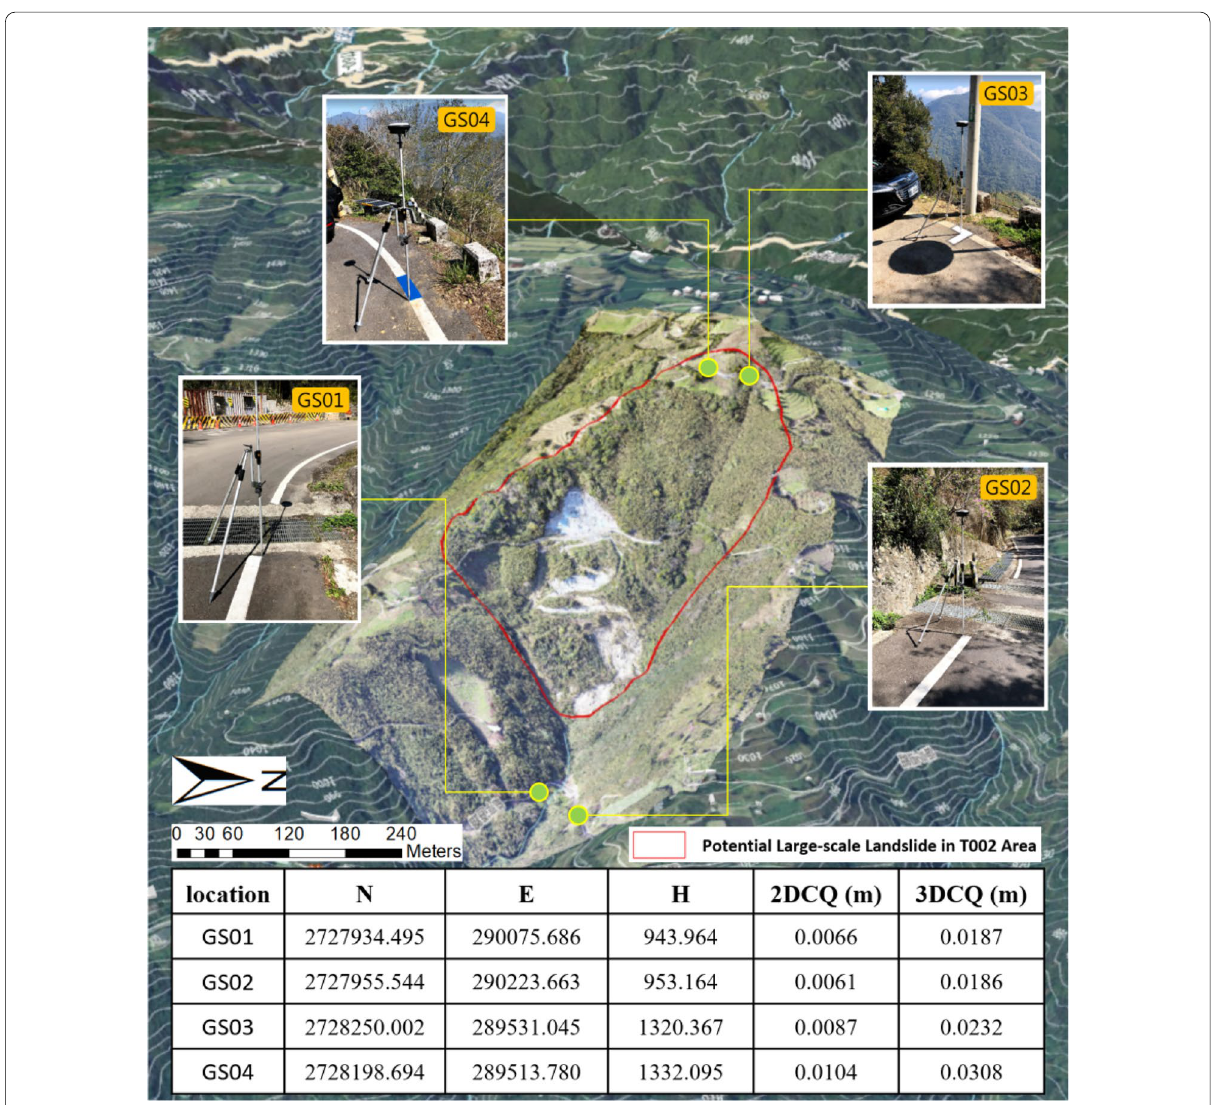
Fig. 7 Locations of ground control points and the coordinates and precision of